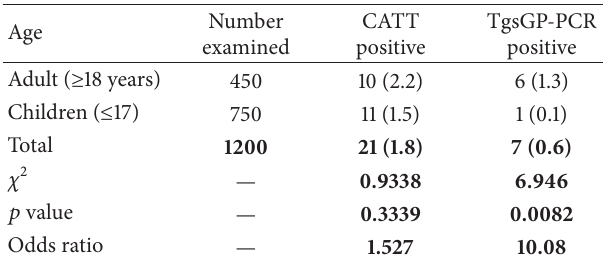
Table 3: PCR and CATT based infection rates of Trypanosoma brucei gambiense in relation to